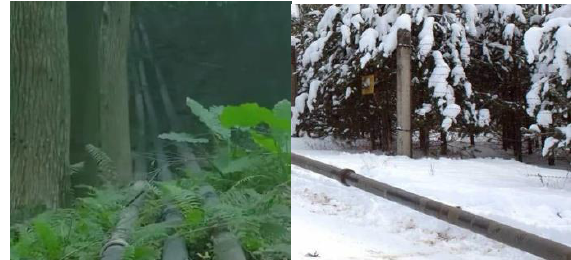
Figure 1. Mobile pipeline laid in the field.